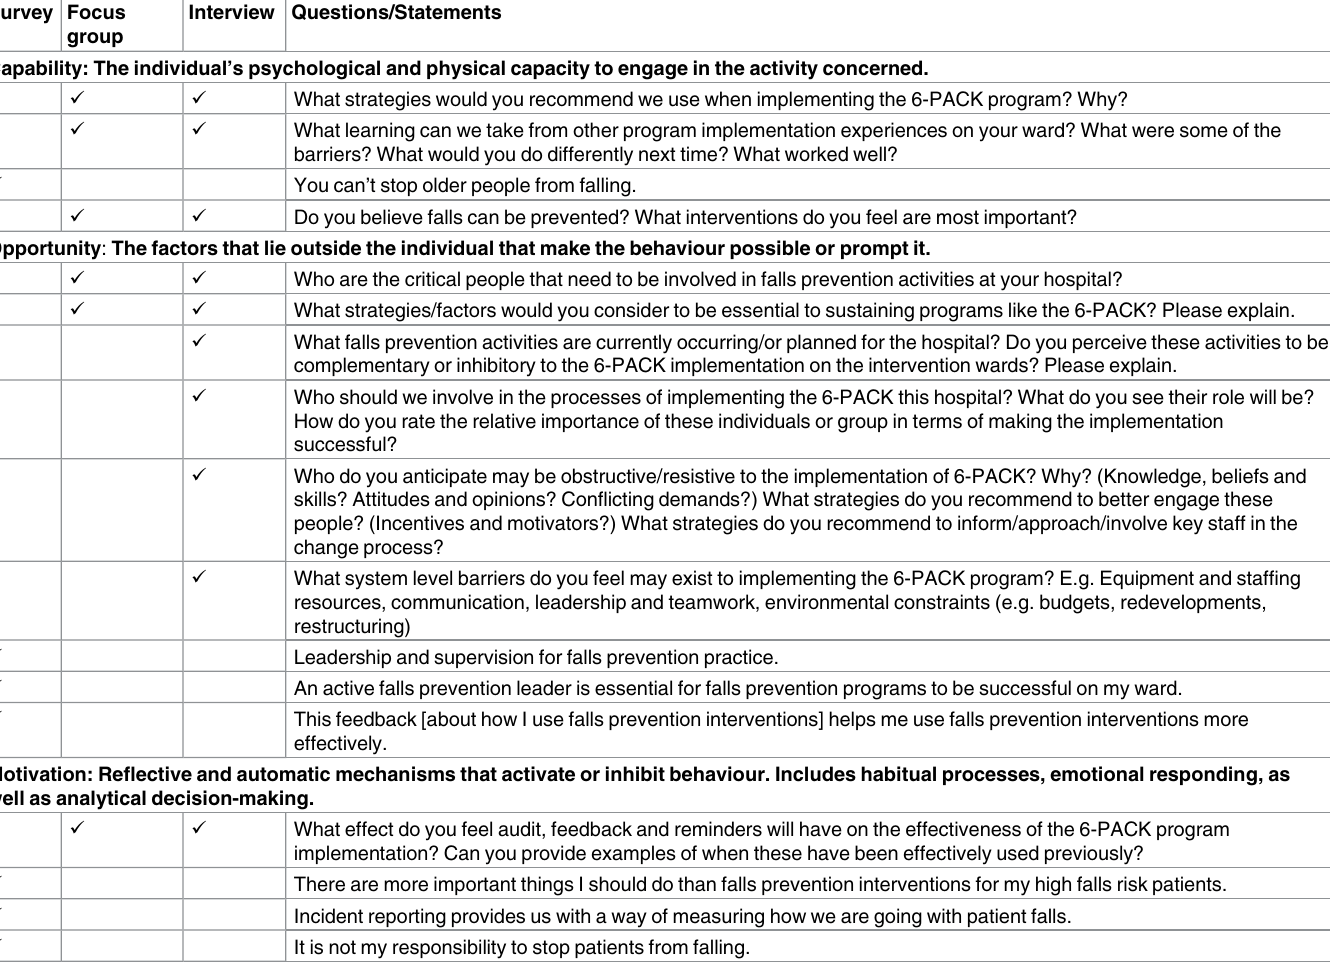
Table 1. Mapping of survey,focus group and interview questions to the COM-B domains [11]. Survey Focus